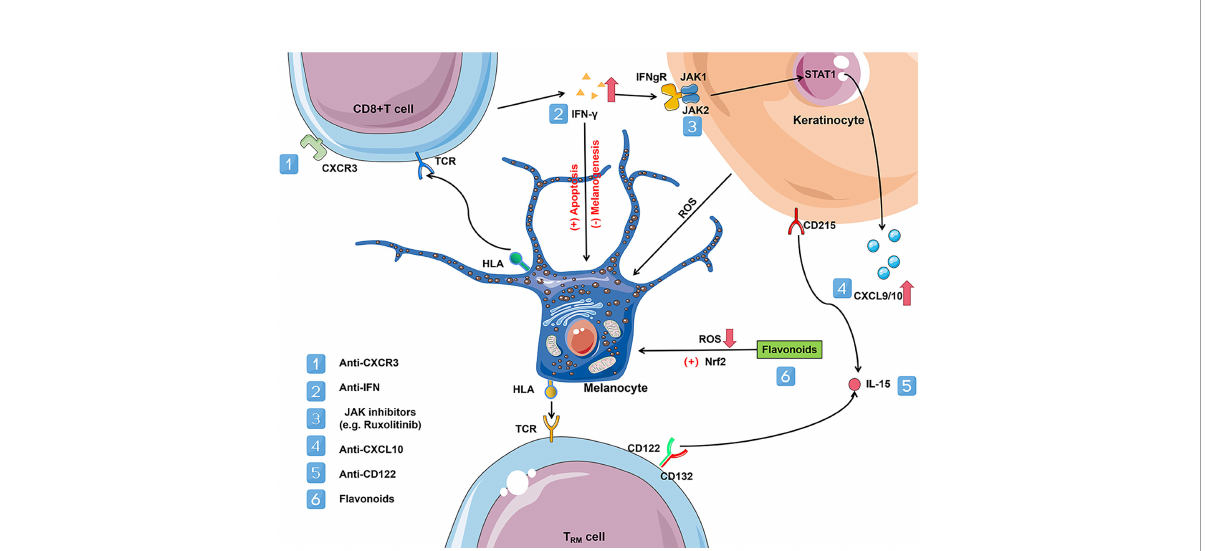
FIGURE 2 Vitiligo immunometabolism promising targets. CD8 + T cells in vitiligo lesions can produce a variety of cytokines, including IFN- g . Elevated levels of IFN- g disrupt glucose metabolism and promote melanocyte apoptosis. IFN- g binds with IFNgR, activates the JAK-STAT pathway, and leads